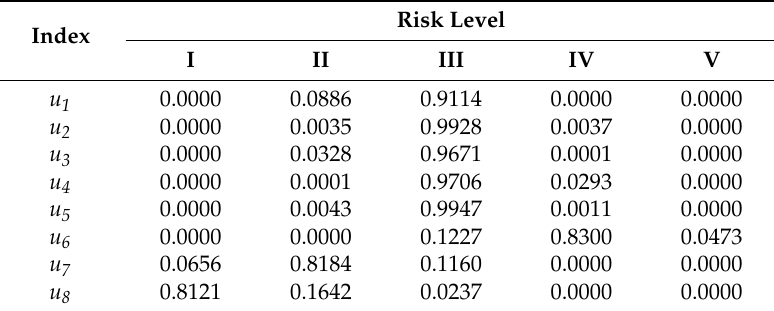
Table 14. Certainty degrees of Tongren City in Guizhou province.